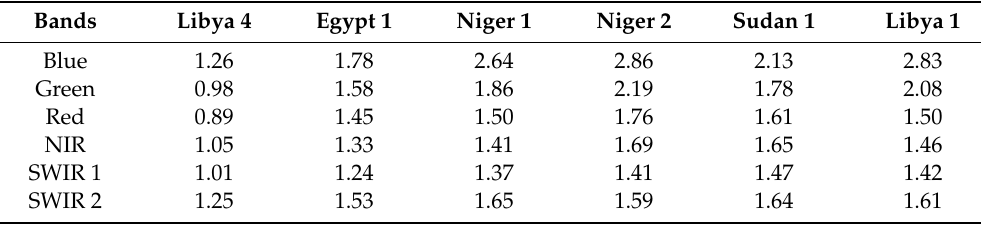
Table 13. Temporal Coe ffi cient of Variation (Standard Deviation / Temporal Mean TOA Reflectance) of 6 selected PICS (%).